Question: Briefly state, in one sentence, what is plotted here.
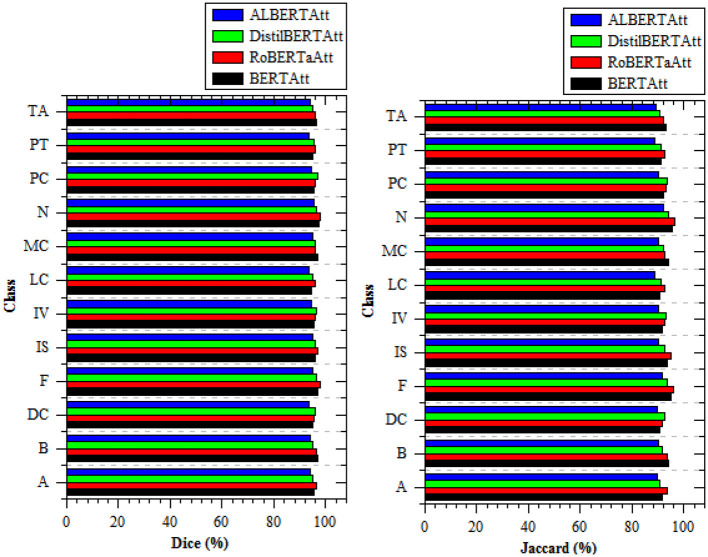
Answer: Results comparison of proposed models for feature extraction. (a) Dice Similarity Index; (b) Jaccard Index on BreakHis dataset.